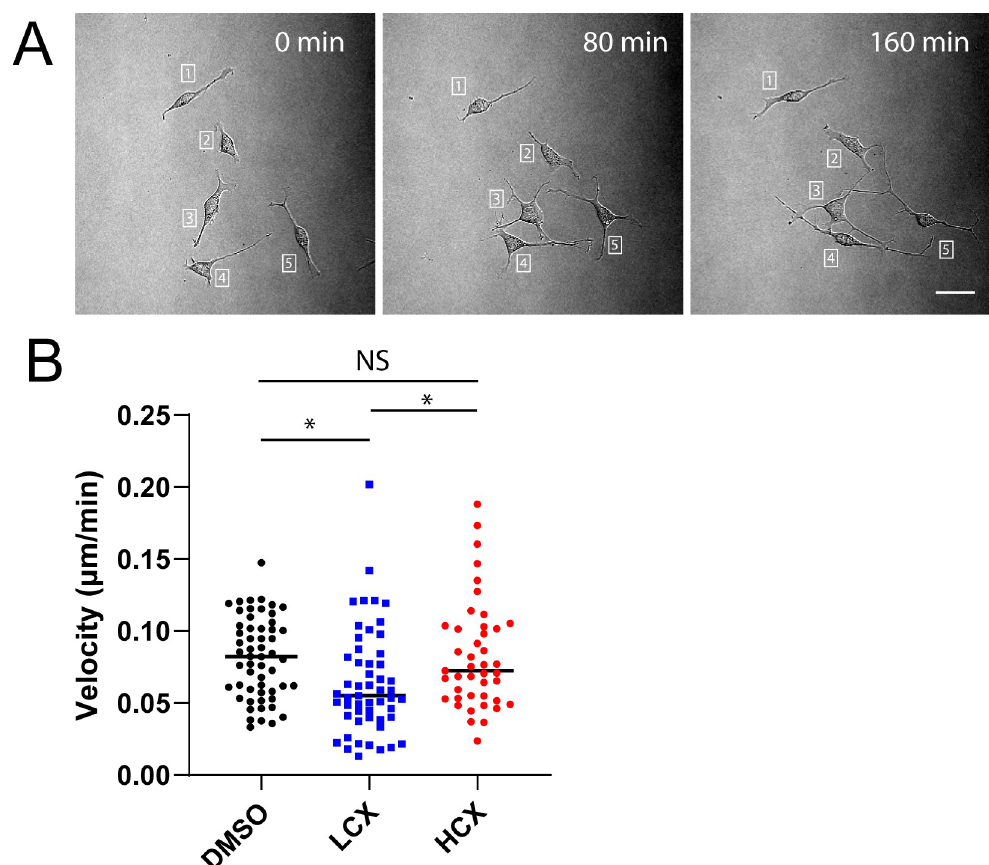
Fig 2. LCX reduces cell migration. Neuro2a cells were observed using time-lapse microscopy. A) Representative images taken at the indicated intervals. Numbers show positions of specific cells. B) Dot plot of velocity of individual cells taken as distance moved in each frame. � p < 0.05. �� p < 0.01. Scale = 25 μ m.